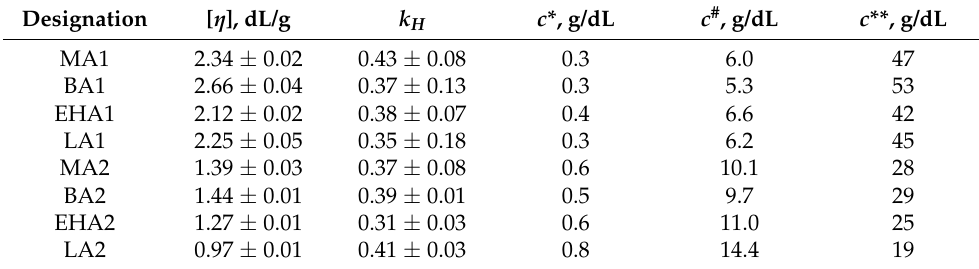
Table 2. Viscometric characteristics of solutions of terpolymers in